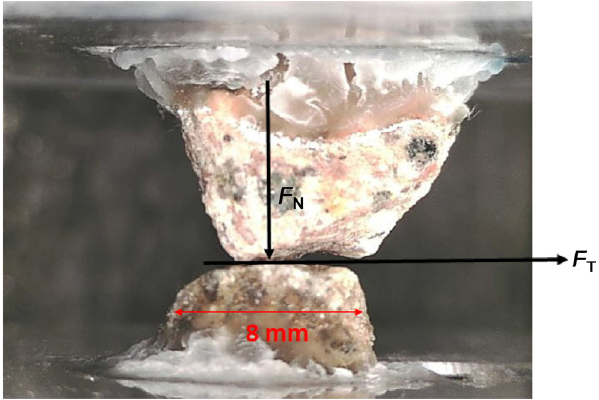
Fig. 6 Image captured by a digital microscope camera during an experiment on the large-size apparatus on crushed granitic granules ( F T is the tangential force and F N is the normal